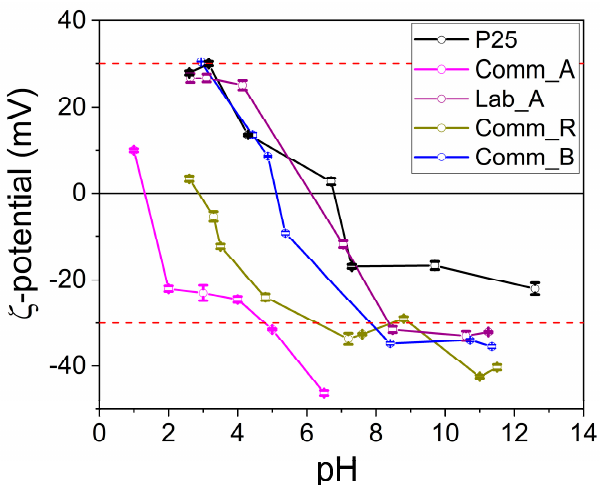
Figure 4. ζ -potential curves of the studied powders.